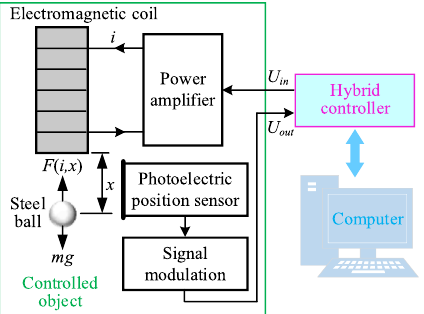
Figure 1. Schematic diagram of the control system physical